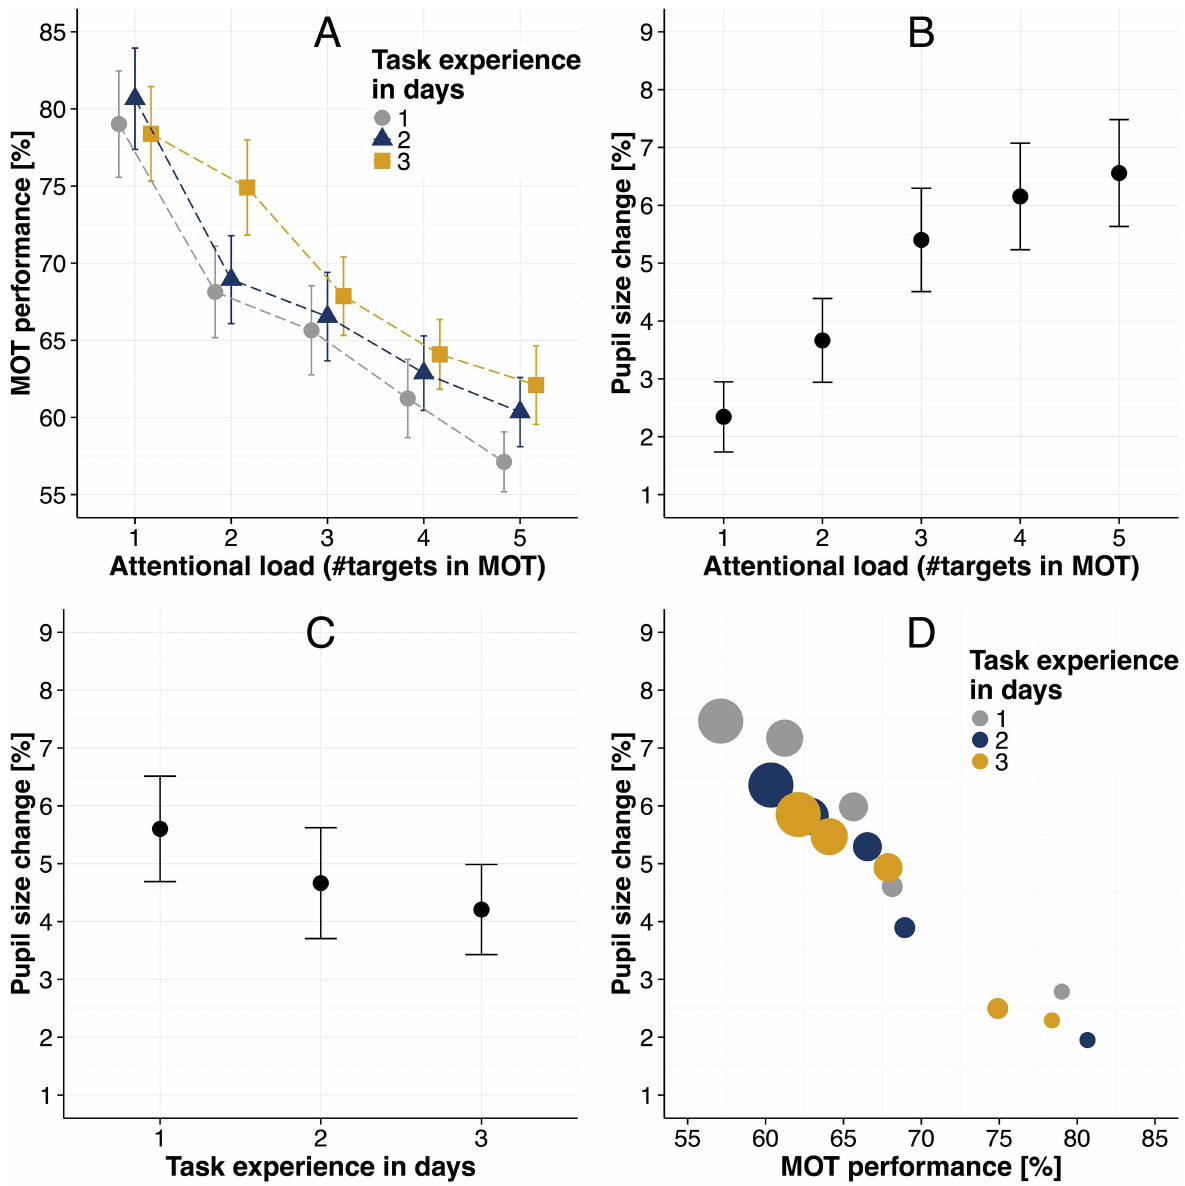
Fig 2. Main experiment results. (A) MOT task performance (i.e., fraction of correctly selectedtargets) as a function of attentionalload and task experience. (B) Pupil size changesrelativeto the passive viewingconditionas a function of attentional load. (C) Pupil size changesrelativeto the passive viewingconditionas a function of task experience. (D) MOT task performance plotted against the pupil size changes,separately for each day. In addition,the number of targets in the MOT task is coded by the sizes of the circles (i.e., with increasing circle size, the number of targets increases). Error bars in all panelsare standarderror of the